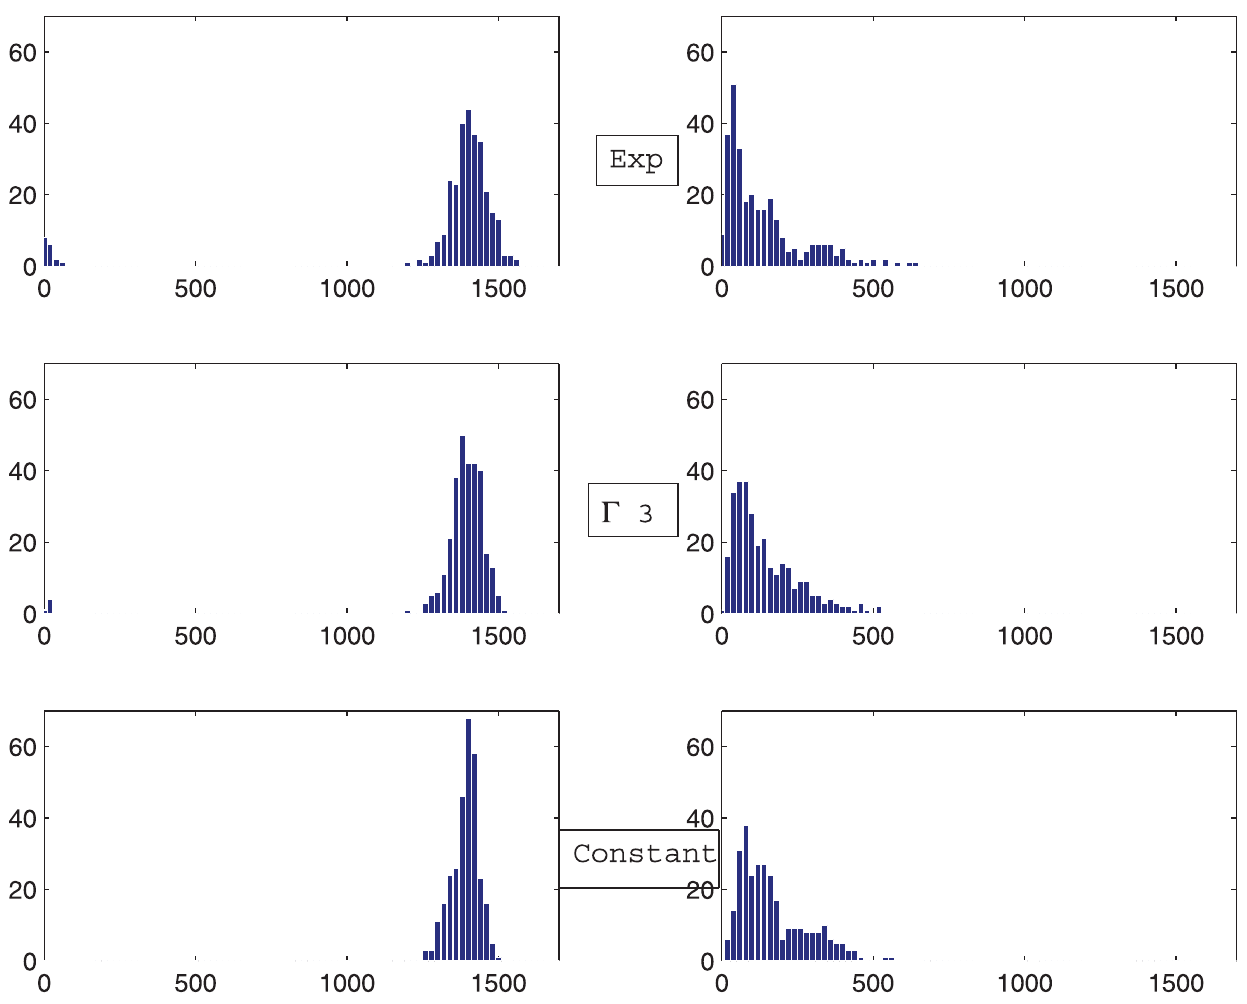
Figure 7. Distribution of the final epidemic size. Calculation was performed on 300 simulations of a stochastic metapopulation model based on a completely connected graph (left panel) and on a scale-free network with mean degree of connectivity equal to 10 (right panel), with T I * Exp( c ) (top graphs), T I * C (3,3 c ) (middle graphs) and T I ~ Const ~ 1 = c (bottom graphs). Parameters values are given at page 10.